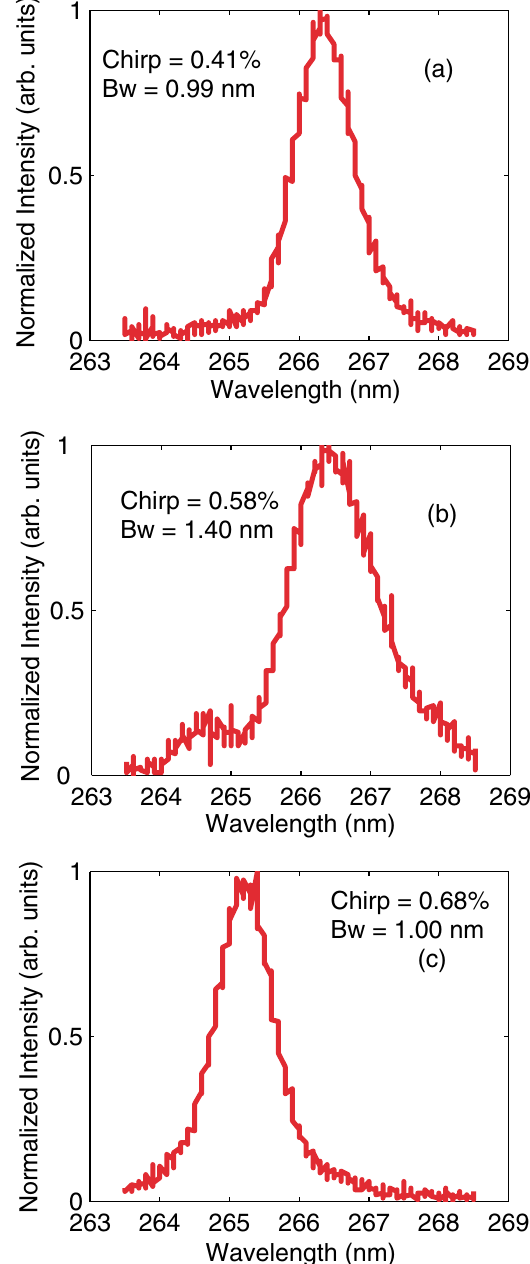
FIG. 15. (Color) (a) Spectrum of CPA-HGHG for a chirp of 0.41%; (b) spectrum of CPA-HGHG for a chirp of 0.58%; (c) spectrum of CPA-HGHG for a chirp of